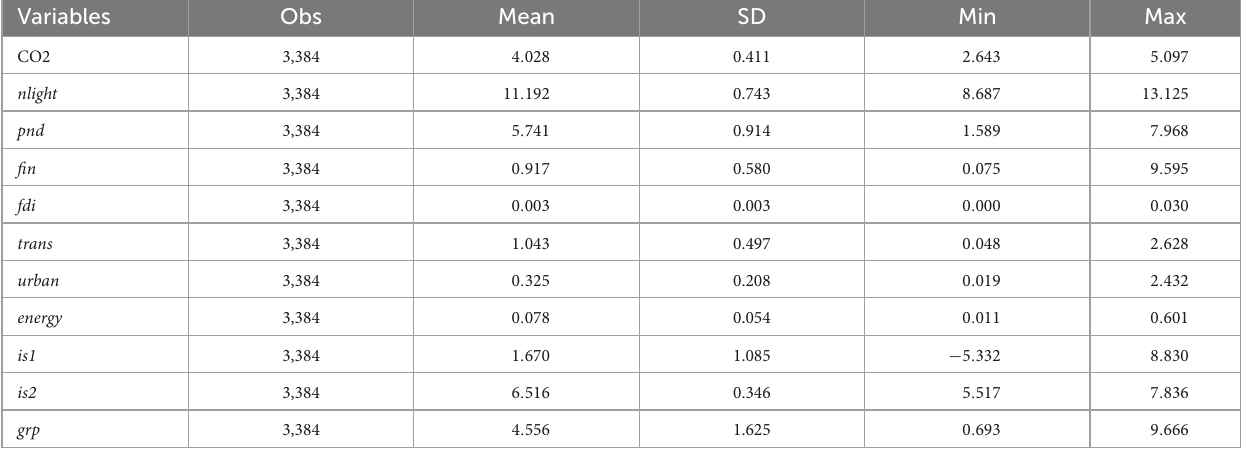
TABLE 2 Benchmark regression